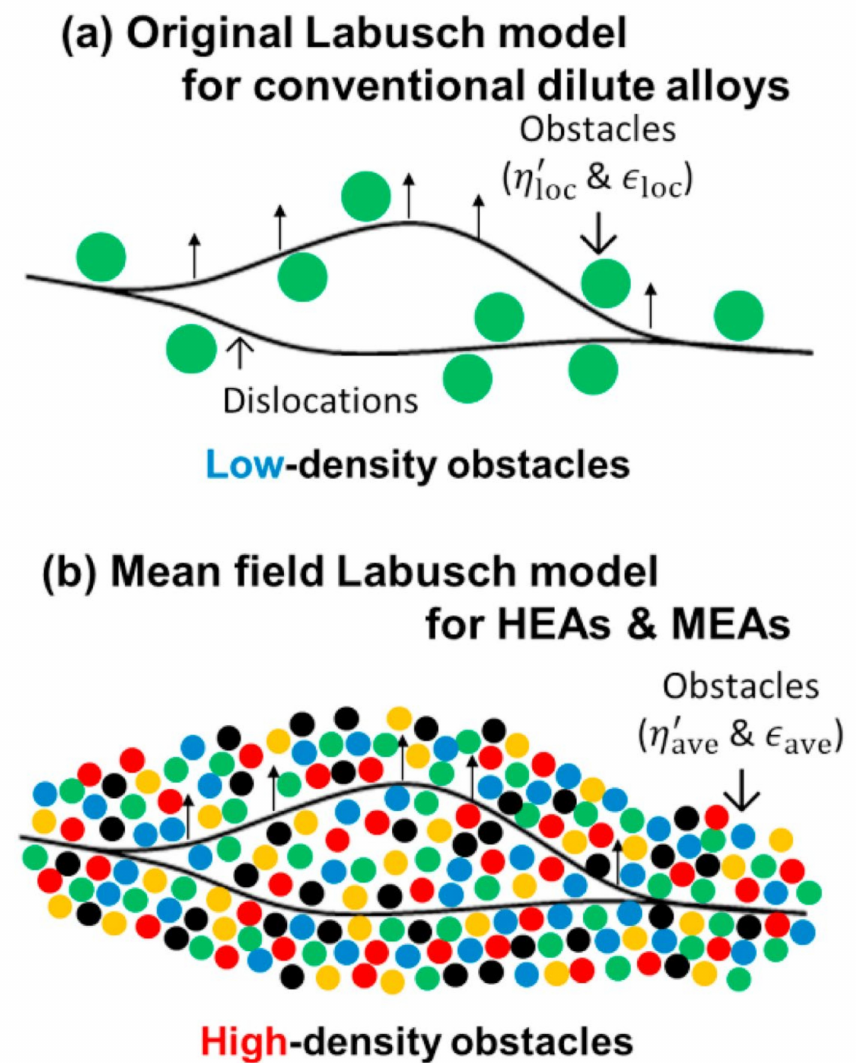
Figure 4. Schematic showing mean field of atoms around dislocation on a slip plane; ( a ) dilute system of typical traditional alloys; ( b ) concentrated system of typical HEAs and MEAs. Adapted from